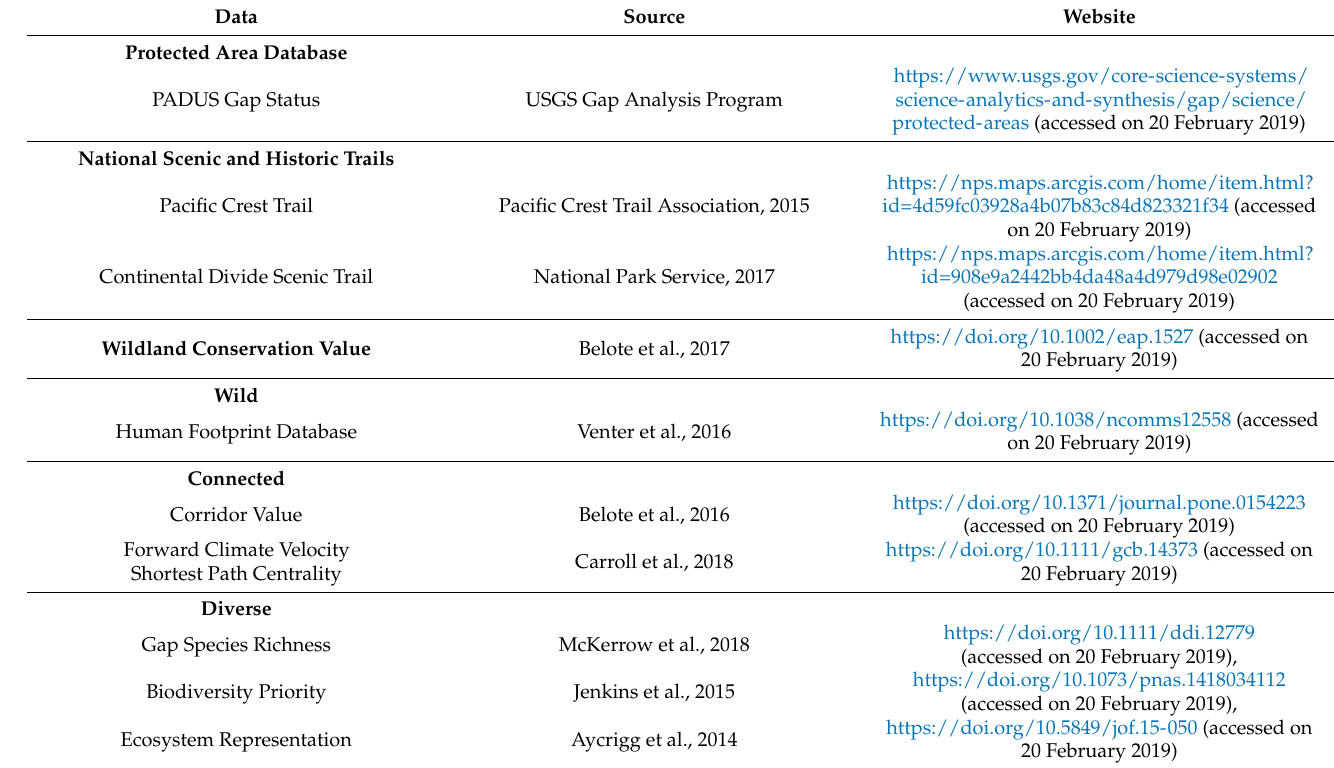
Table 1. Datasets for the assessment of Pacific Crest Trail and Continental Divide